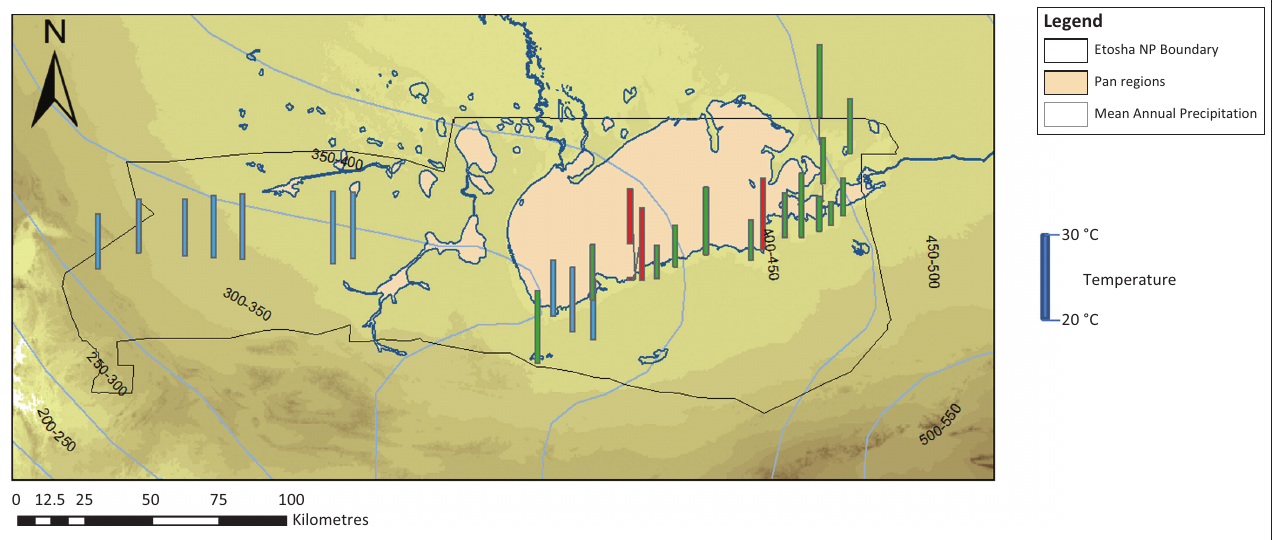
FIGURE 6: Spatial distribution of temperature for different water point types in the Etosha National Park, May